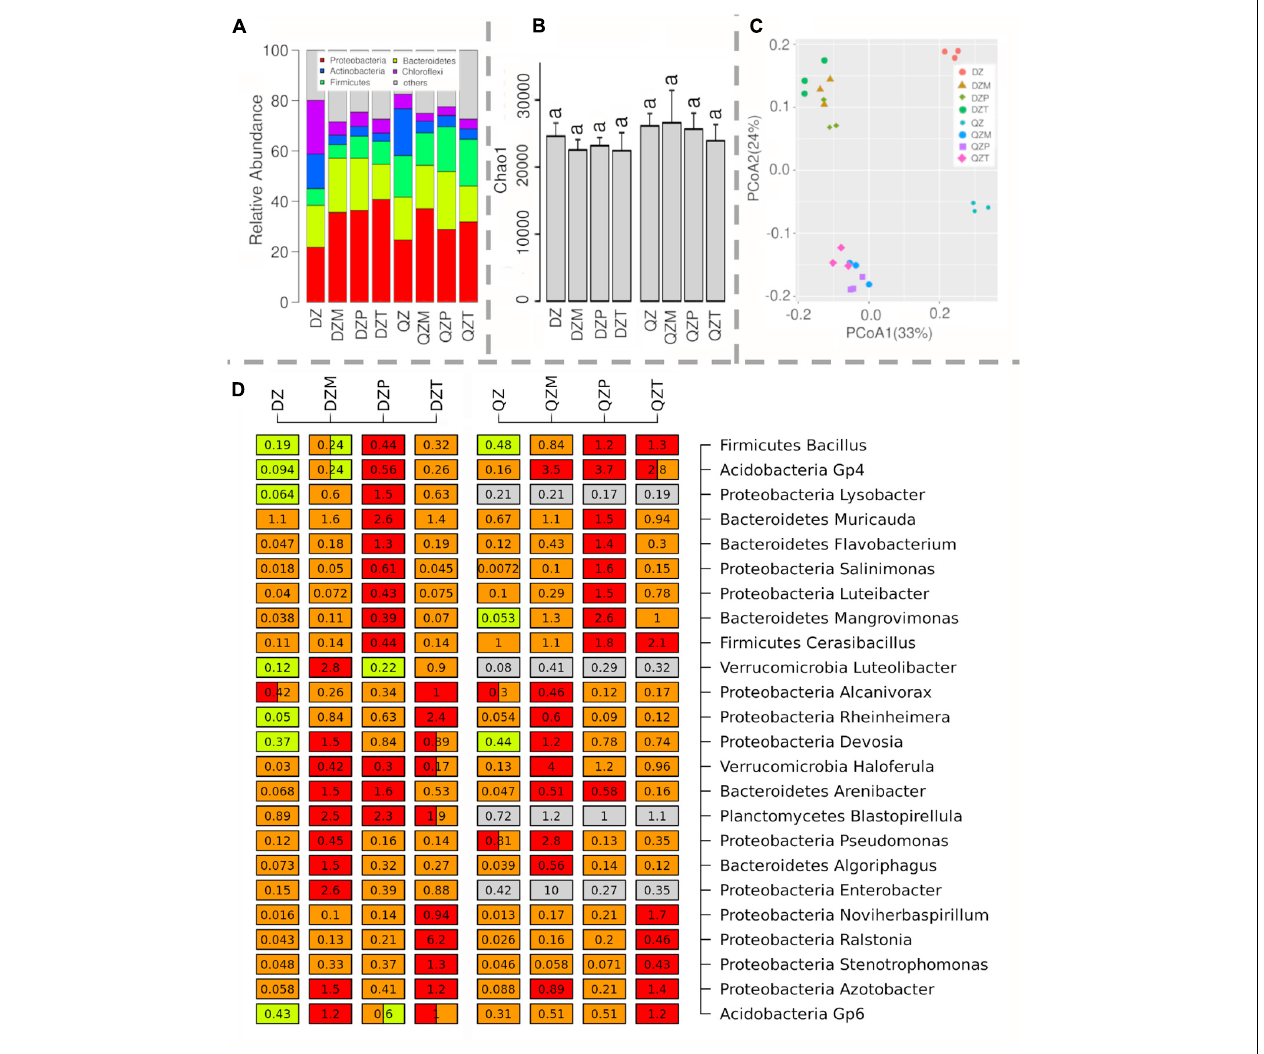
FIGURE 1 | Microbial relative abundance of different phylum (A) and their richness (B) in the rhizosphere of maize (M), pepper (P), and tomato (T) seedlings cultivated in cow manure compost (DZ) and chicken and cow manure co-compost (QZ) by 16S rRNA PCR amplicon sequencing. Principal coordinates analysis (PCoA) showing beta-diversity between rhizosphere and compost or between different composts (C) . Genera enriched at different rhizosphere under two compost treatments (D) . Numbers on the box indicate relative abundance expressed as a percentage. Significant difference is indicated by a different color. A box with two colors indicates no significant difference from other treatments containing one of the two colors. Significant differences are indicated by different